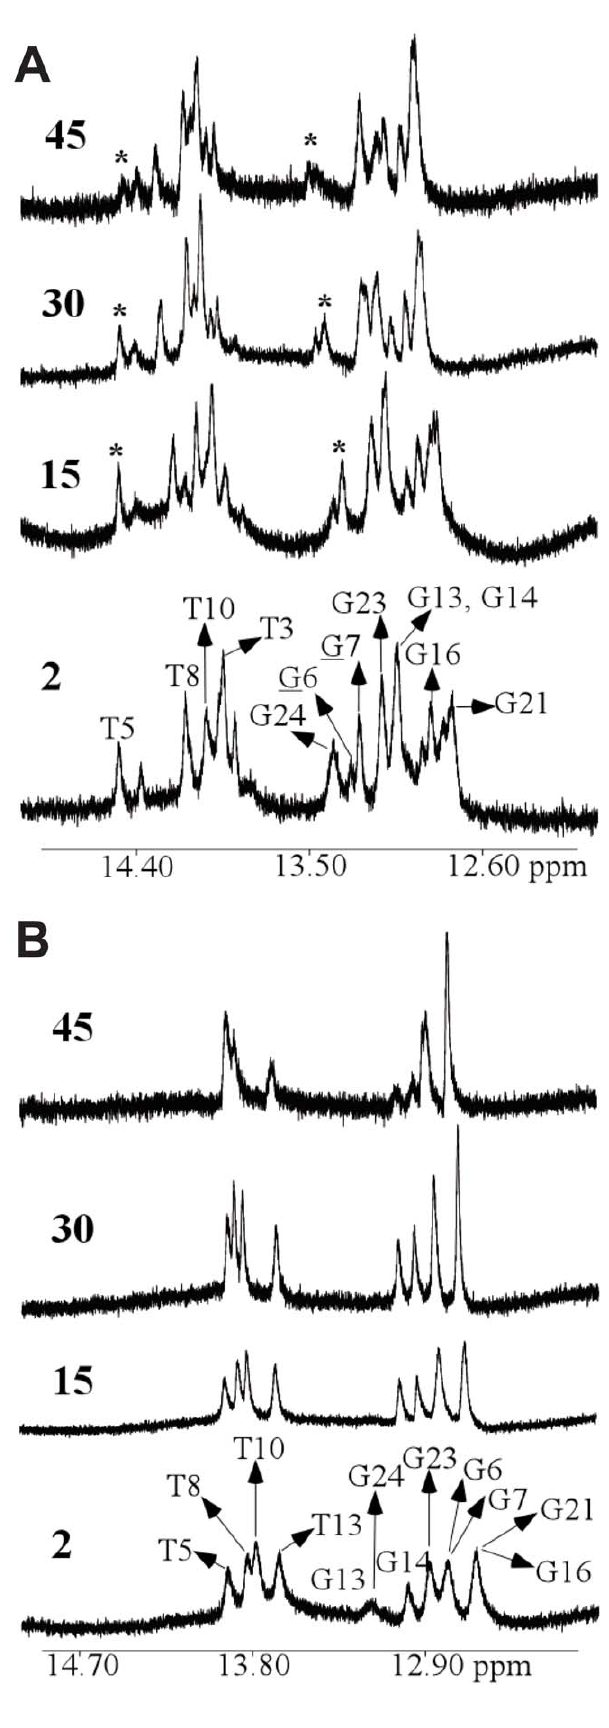
Figure 5. Temperature dependence of the imino proton signals by 1D NMR. Expanded imino region from 1D 1 H-NMR spectra of the OX-DNA ( A ) and undamaged DNA ( B ) duplexes recorded in an H 2 O buffer at various temperatures ( u C). The positions of the nucleotides in the 12-mer duplexes that give rise to the resonances are indicated. The asterisk (*) in the 1D 1 H-NMR spectra of the OX-DNA adduct indicates the position(s) of the G6, G7, and T5 residues. The experimental temperatures are shown on the left. Also see Tables S1, S2 and